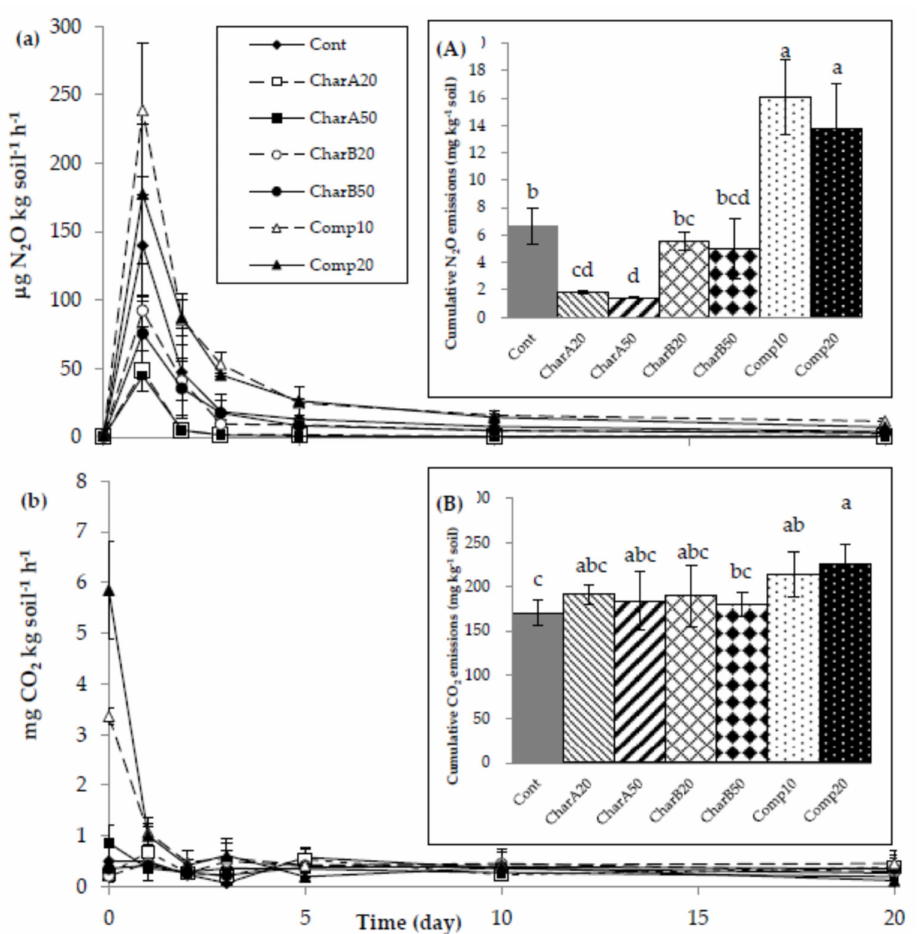
Figure 3. Fluxes of N 2 O ( a ) and CO 2 ( b ) emissions from soil amended with biochar or compost. Bar charts represent cumulative N 2 O ( A ) and CO 2 ( B ) emissions over 20 days. Emission rates are expressed as average values from three replicates. Columns with di ff erent letters indicate a significant di ff erence ( p < 0.05) among treatments. Error bars indicate the standard deviation of three replicates (n = 3) for each treatment. Cont, soil without amendment; CharA20, soil + 20 g kg − 1 of Biochar A; CharA50, soil + 50 g kg − 1 of Biochar A; CharB20, soil + 20 g kg − 1 of Biochar B; CharB50, soil + 50 g kg − 1